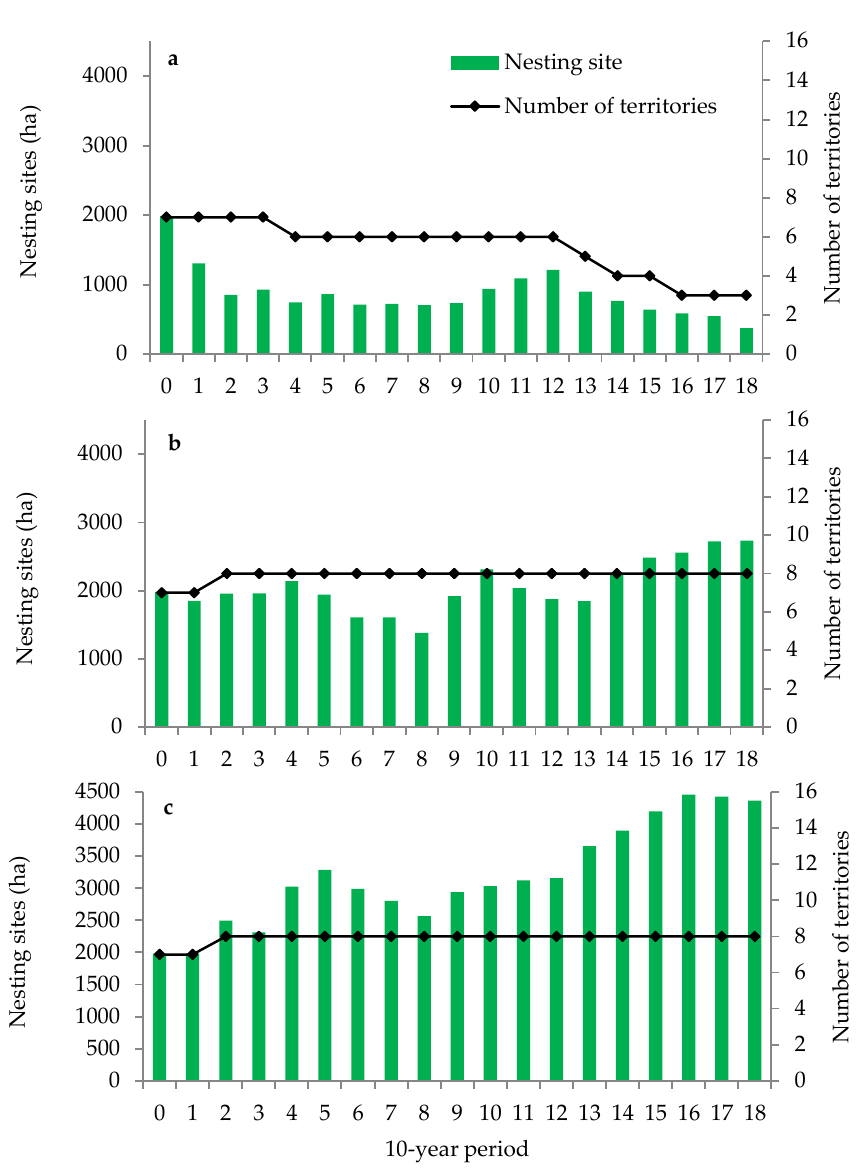
Figure 4. Area of nesting sites (bars) and the number of potential nesting territories (line) in the various management scenarios during 180 years of simulation ( a ) PR—productive scenario, ( b ) BA—basic scenario, ( c ) LR—long rotation scenario).